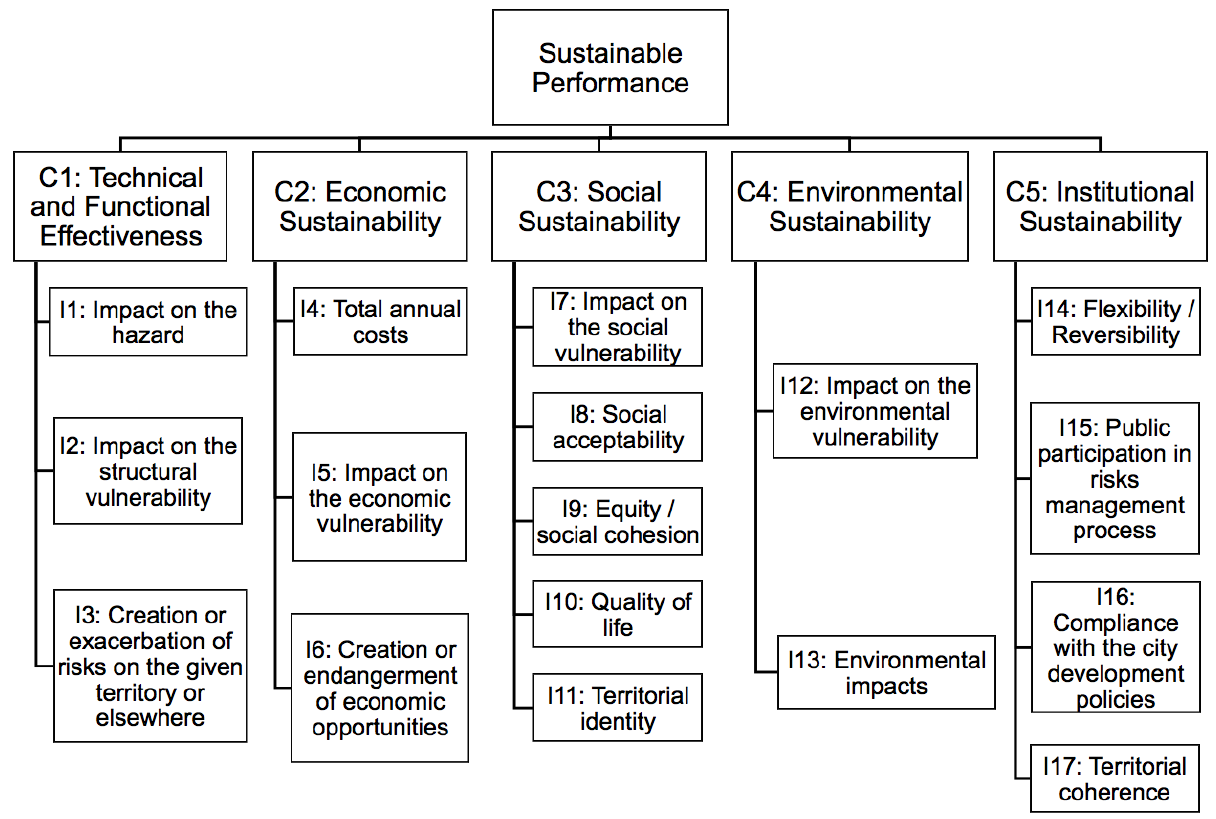
Figure 2. Hierarchical structure of the sustainability assessment grid (source: